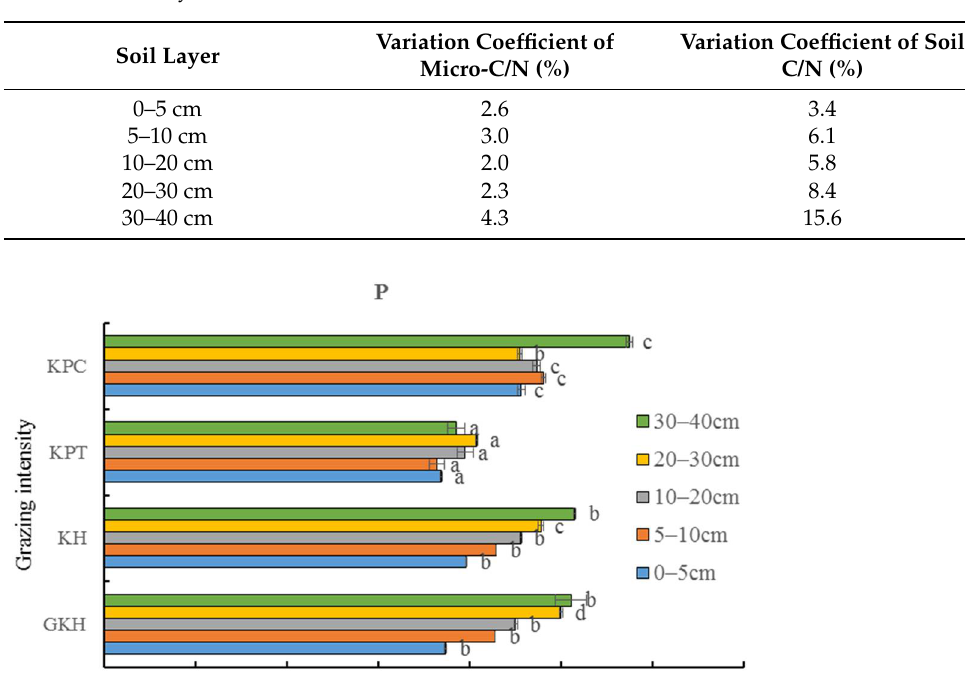
13 of 19 Figure 11. Concentrations of microbial carbon (C) ( A ) and nitrogen (N) ( B ) at different grazing in- tensities: GKH (3.75 ± 0.75 sheep/ha), KH (7.25 ± 0.25 270 sheep/ha), KPT (8.50 ± 0.35 sheep/ha), and KPC (11.75 ± 0.95 sheep/ha). Notations: different letters indicate significant differences between pas- tures ( α = 0.05). 3.5. The Relationships b etween Plant Community Yield, Soil Nutrients and Soil Microbes Mediated by C and N u nder Overgrazing The C/N stoichiometry in soil microorganisms remained stable with a range of coef- ficients from 2.0 to 3.0% at 0 to 30 cm, which were lower than those of total soil C/N (3.4 to 8.4%) (Table 3). The variation coefficient of soil microorganism C/N and total soil C/N